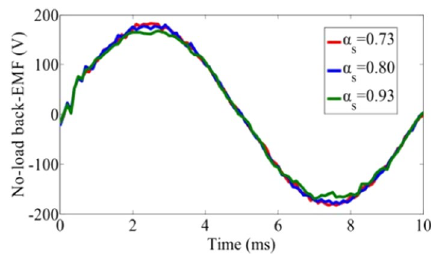
Figure 15 Comparison of back EMFs for various shoe-width ratios